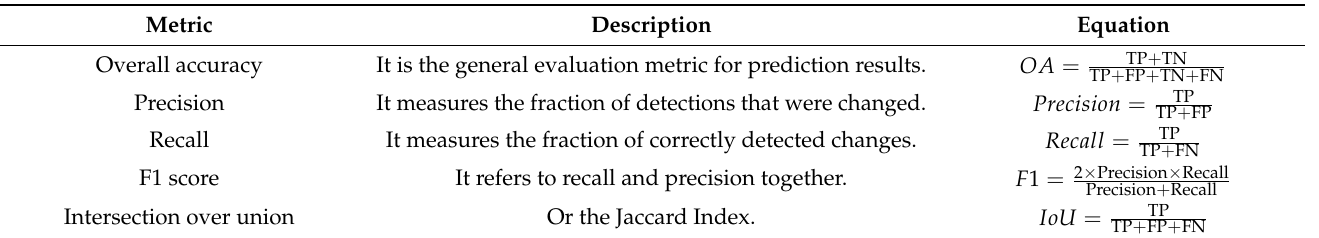
Table 5. Definitions of evaluation metrics for 3D point cloud